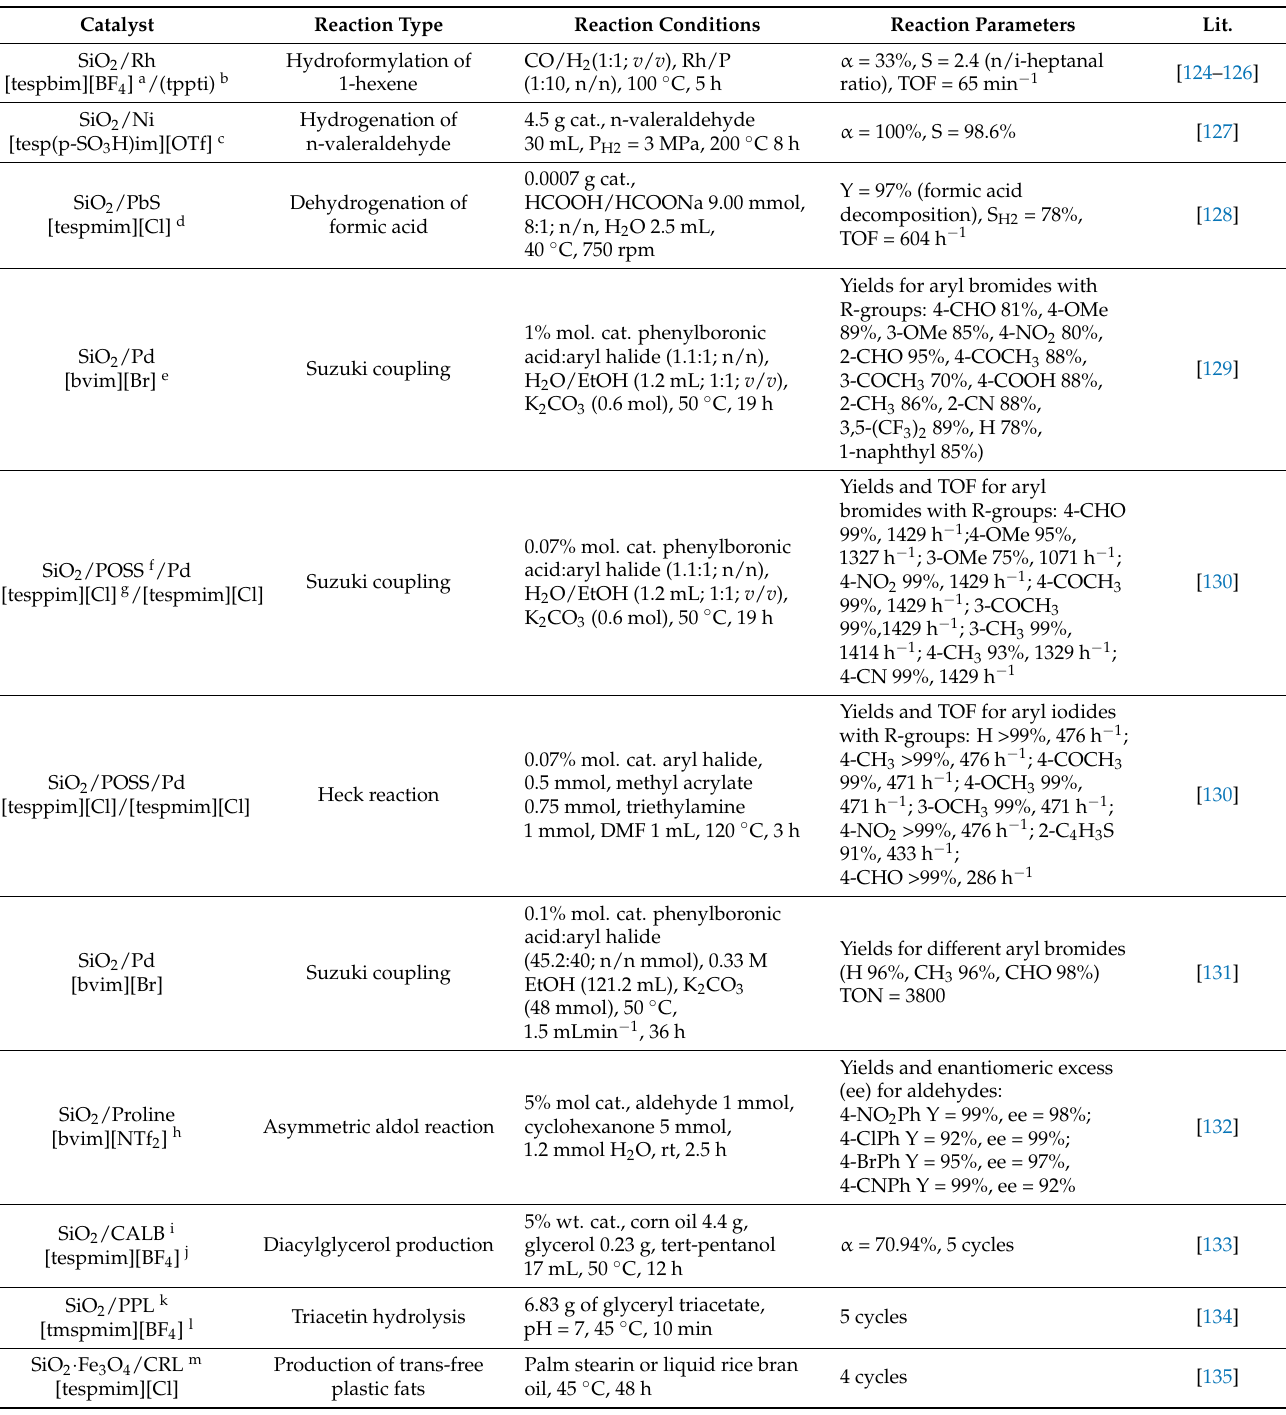
Table 4. Examples of silica-based SILLP as a matrix or co-catalyst in organic